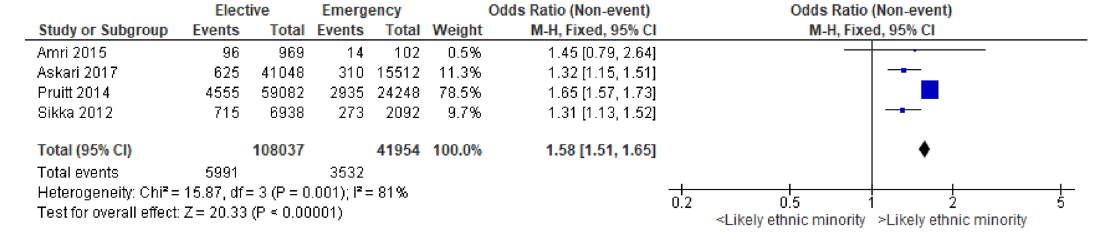
Figure 13. Association between ethnicity and emergency presentation—Forest Plot.